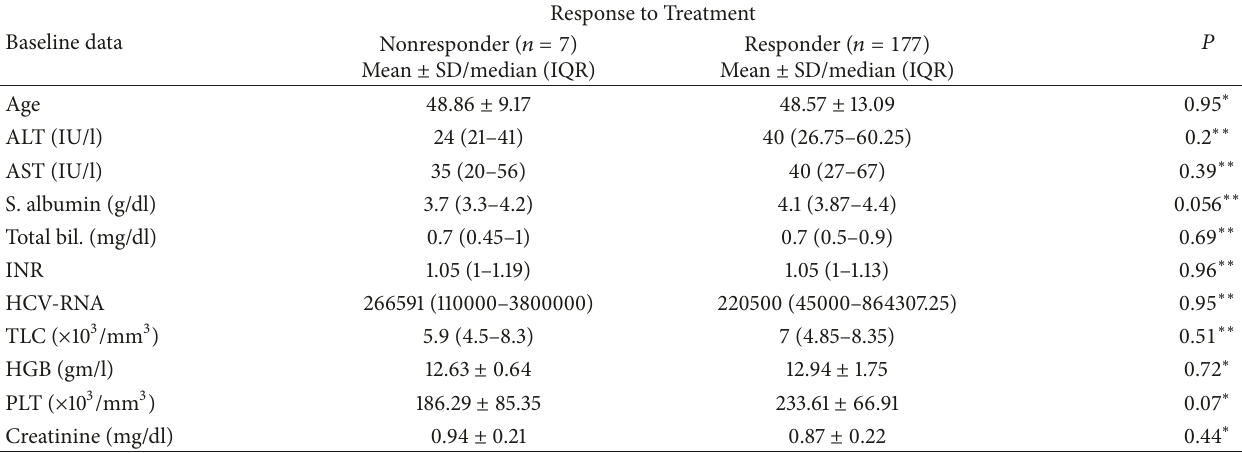
Table 1: Relation between patients’ age and baseline biochemical parameters and achievement of